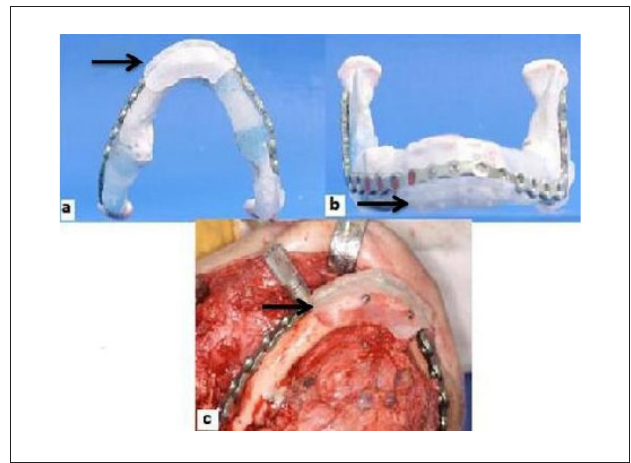
Fig. 2. Plates are bent at the biomodels and trans-operative guides (arrows) are made (a, b) to make easier the bone plate to be installed (c) found that the percent difference was 0.08% with a